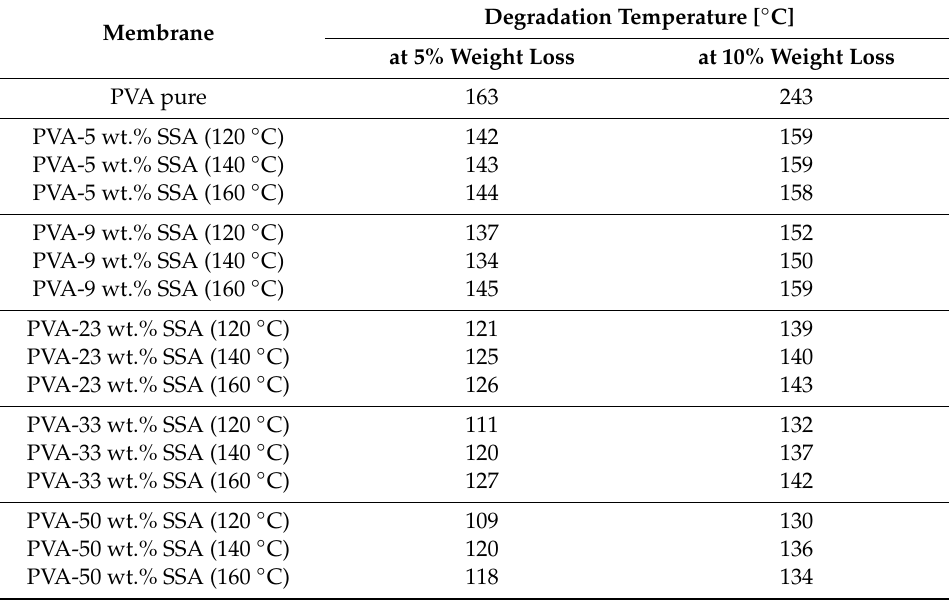
Table 1. Characteristic degradation temperature of the studied PVA-SSA membranes.